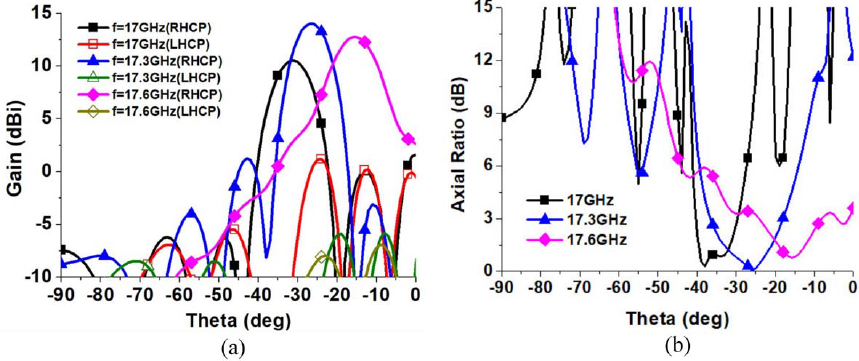
Figure 12. ( a ) Simulated gain and ( b ) simulated axial ratio of the proposed antennas that generate RHCP in the x–z plane at 17 GHz, 17.3 GHz, and 17.6 GHz, respectively. The simulated radiation efficiency of the designed antenna is shown in Figure 13.